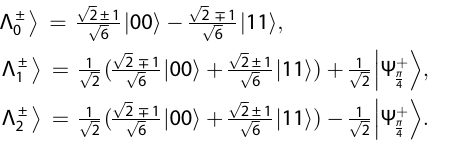
(black), γ 0 (red), 0 þ , γ (cid:6) and γ (cid:6) Þ : when 0 < ϵ < π 0 þ 2 4 , γ (cid:6) and γ (cid:6) are non-positive. (cid:5) ϵ < π 0 (cid:2) 4 2 , there are two 4 , it (cid:5) ϵ < π 4 2 and r = 3